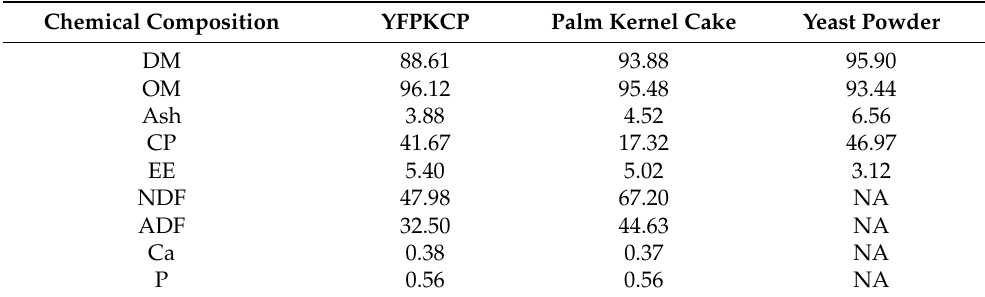
Table 1. Chemical composition of yeast fermented palm kernel cake, oil palm meal, palm kernel, cake, and yeast powder (% DM basis).